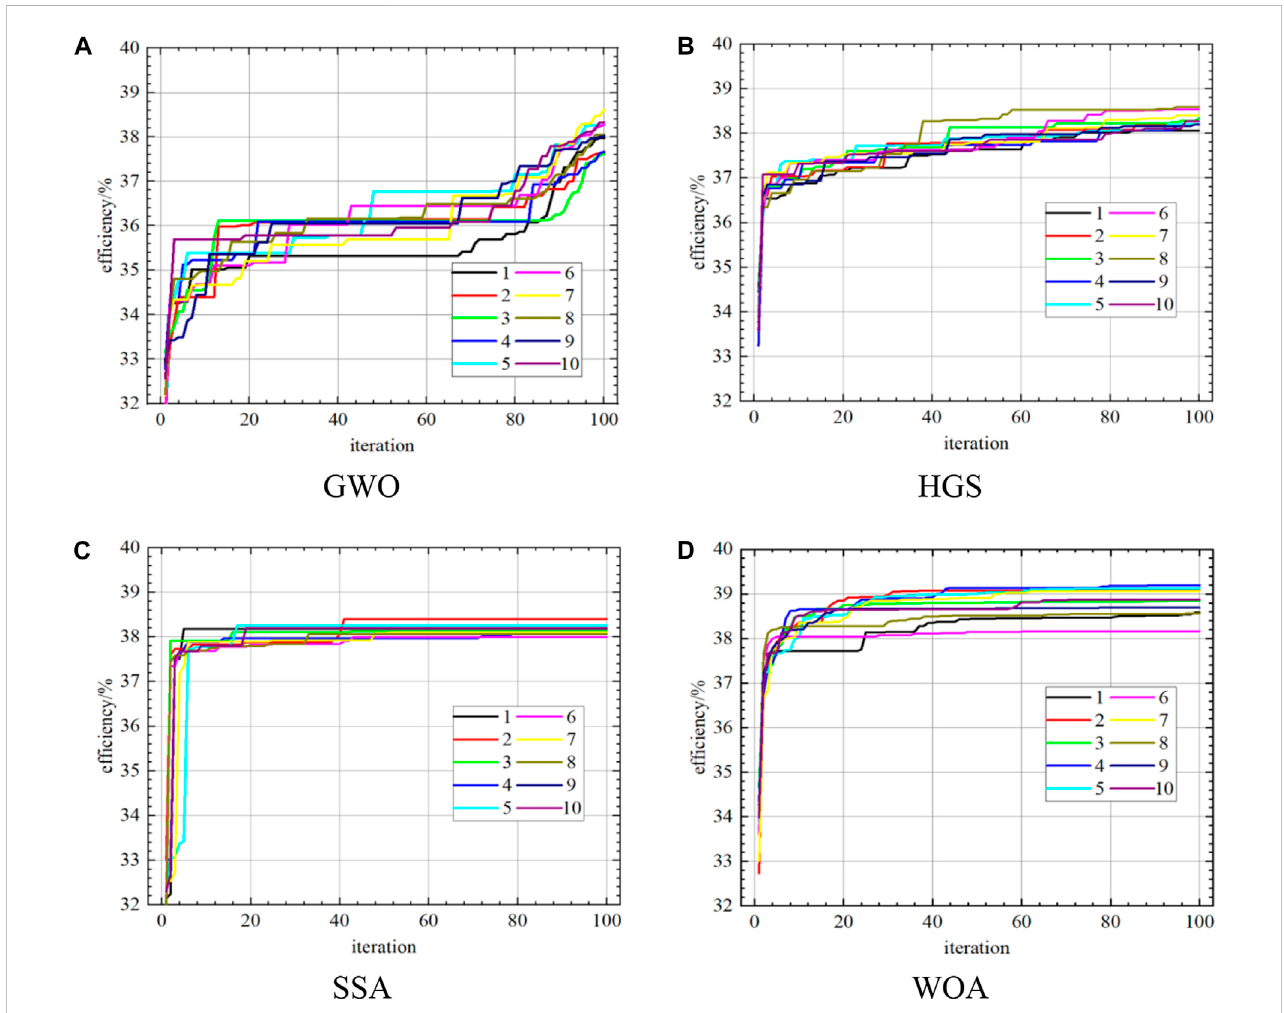
FIGURE 3 Trend of optimized detection ef fi ciency of different algorithms.